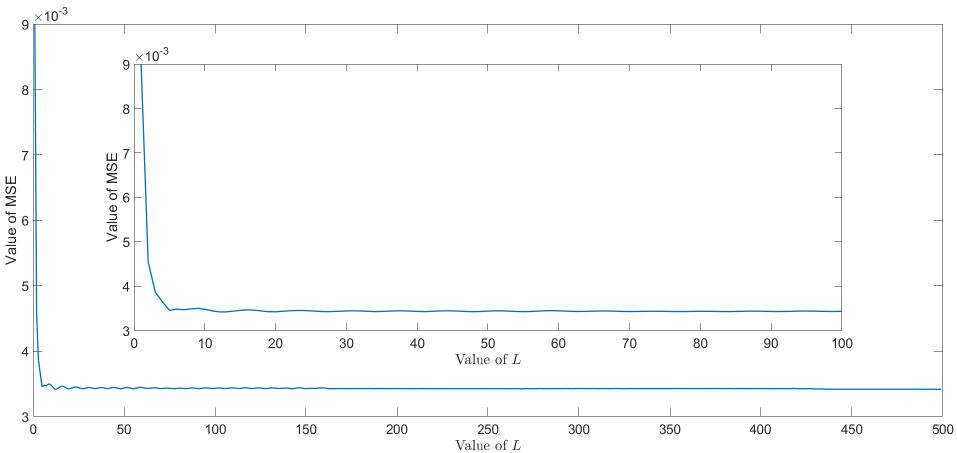
Figure 3. MSE for the first proposed method used to determine the non-zero initial conditions vector.